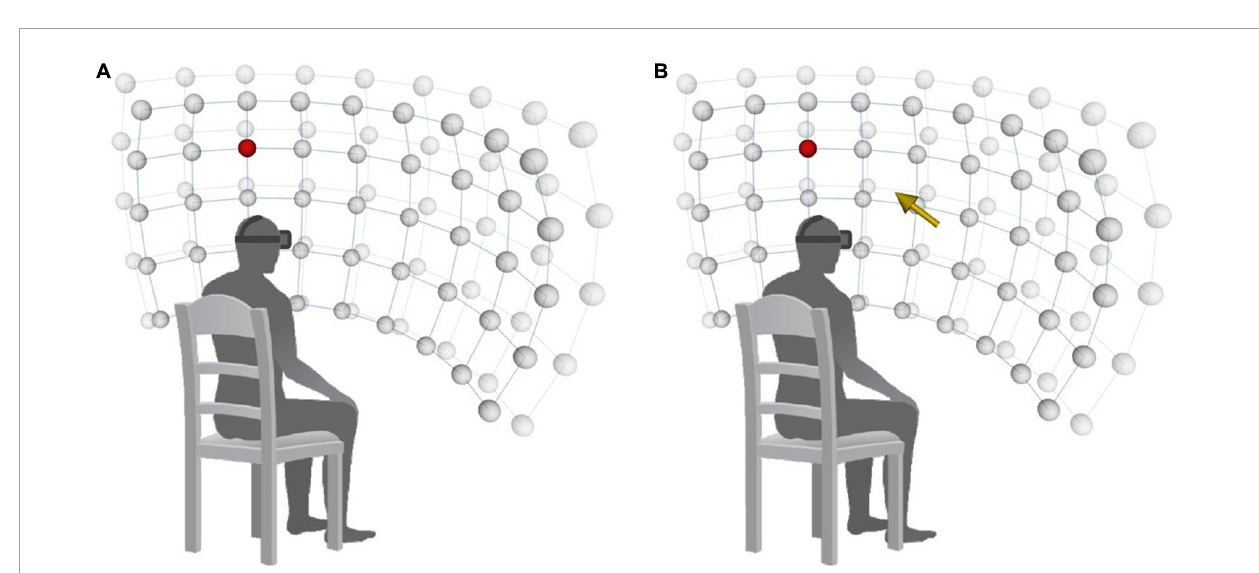
FIGURE2 Arrangement of stimuli on a 9 × 5 × 2 spherical coordinate system. (A) VR-VET-no cue. (B) VR-VET-cue. VR-VET, virtual reality-based visual exploration therapy.